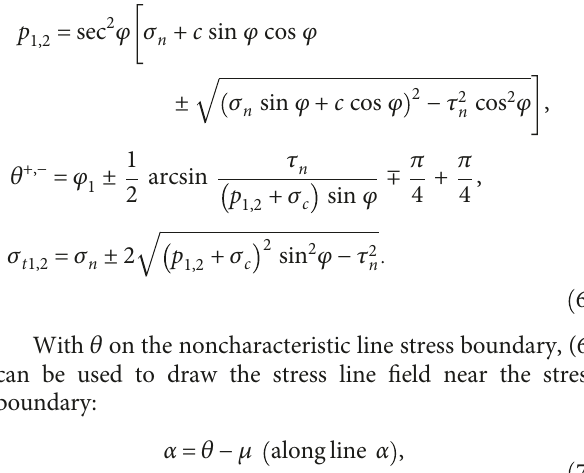
Figure 3: E ff ective stress of Mohr ’ s